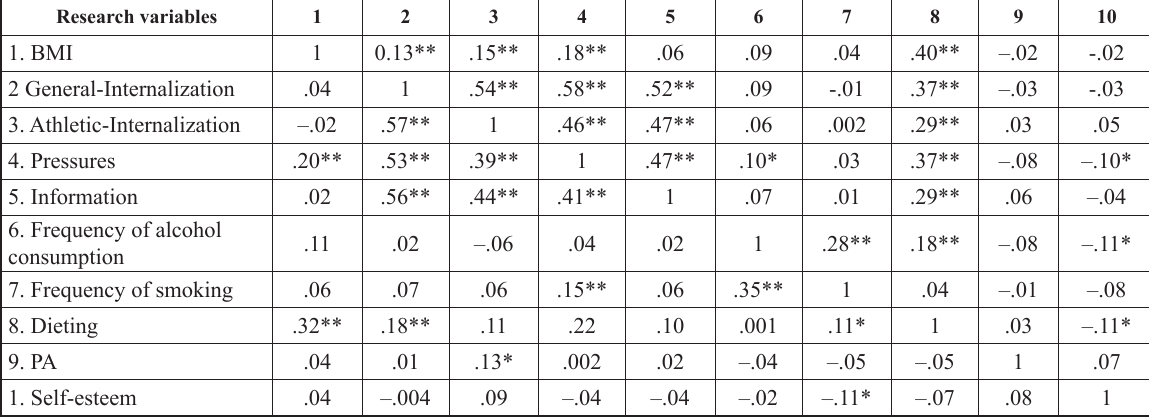
Table 3. Correlation (Spearman’s coefficients) among sociocultural attitudes towards appearance, harmful habits, physical activity and self-esteem in the groups of boys and